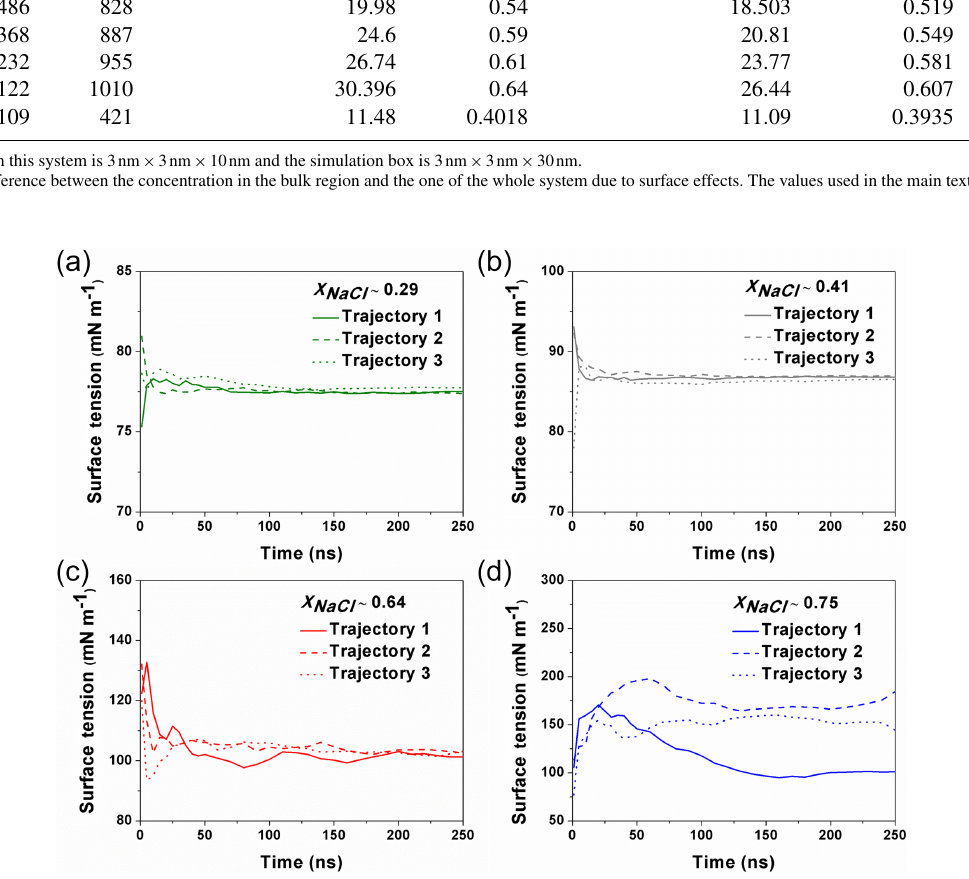
Figure 1. The calculated surface tension at different simulation time from different trajectories. For the solution with x NaCl ≤ 0 . 64 (a–c) , the surface tension become steadily stabilized after ∼ 100–150ns, and different individual simulation runs converge to a similar result. When x NaCl > 0 . 64 ( d ; here x NaCl = 0 . 75), the surface tension keeps fluctuating and the final values from different individual simulations cannot be converged even after